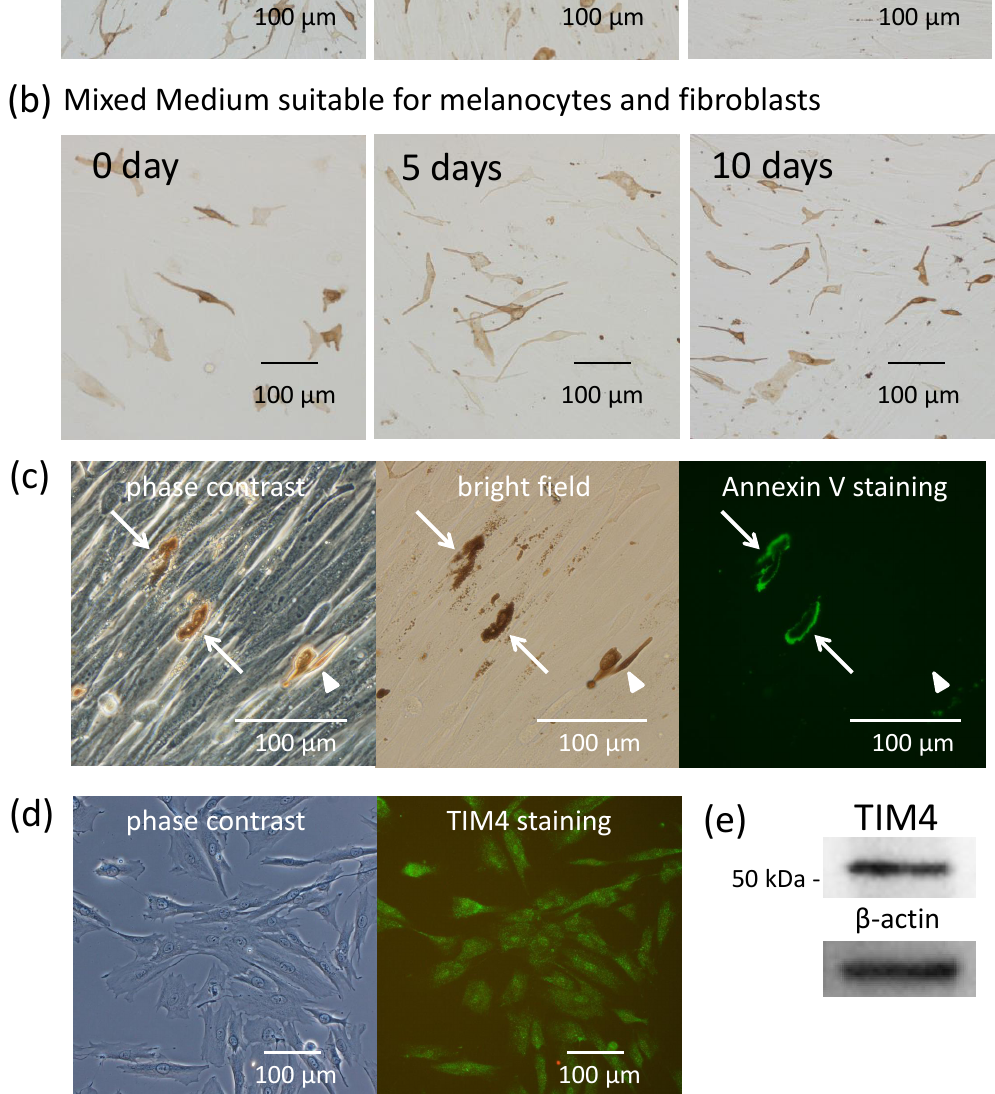
Figure 4. Normal human fibroblasts internalize apoptotic melanocytes and express TIM4. Time-dependent observations of melanocytes and fibroblasts co-cultured in medium suitable only for ( a ) fibroblasts or ( b ) in medium suitable for melanocytes and fibroblasts. The same fields with (left) phase contrast, (middle) bright field and (right) immunofluorescence staining of PtdSer by Annexin V showing ( c ) the manner of internalization of apoptotic melanocytes into fibroblasts. Arrows indicate apoptotic melanocytes with exposed PtdSer. Arrow-heads indicate a clear-shaped and distinctive melanocyte with no staining of Annexin V. ( d ) Immunofluorescence staining and ( e ) Western blotting of TIM4, a receptor for PtdSer, in fibroblasts is